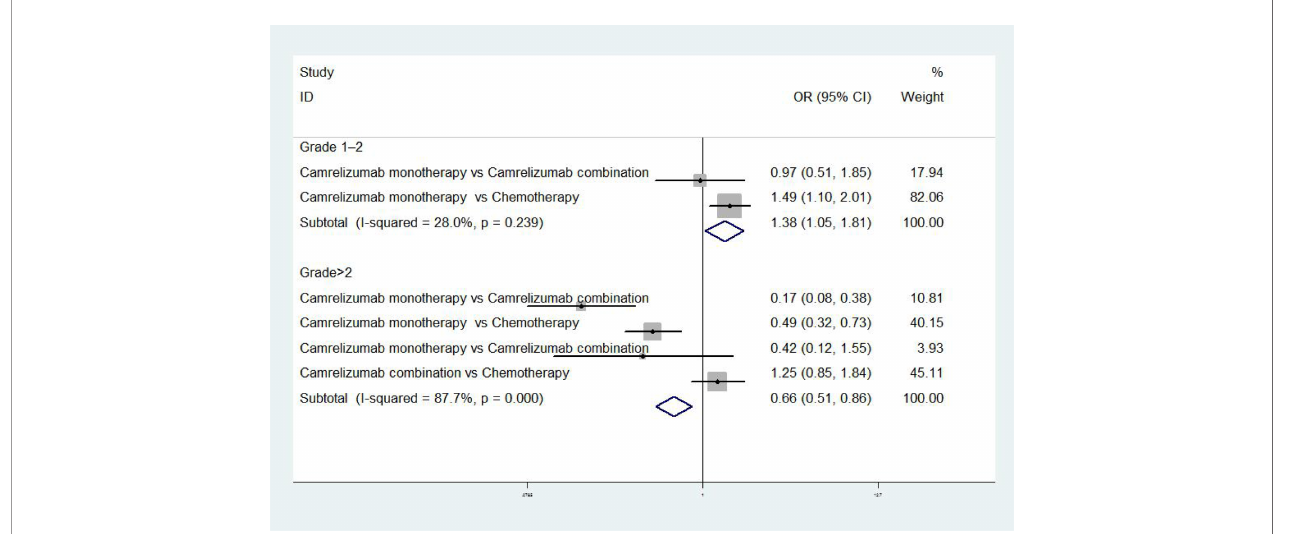
FIGURE 3 | Meta-analysis of safety of single and combined treatment of camrelizumab.